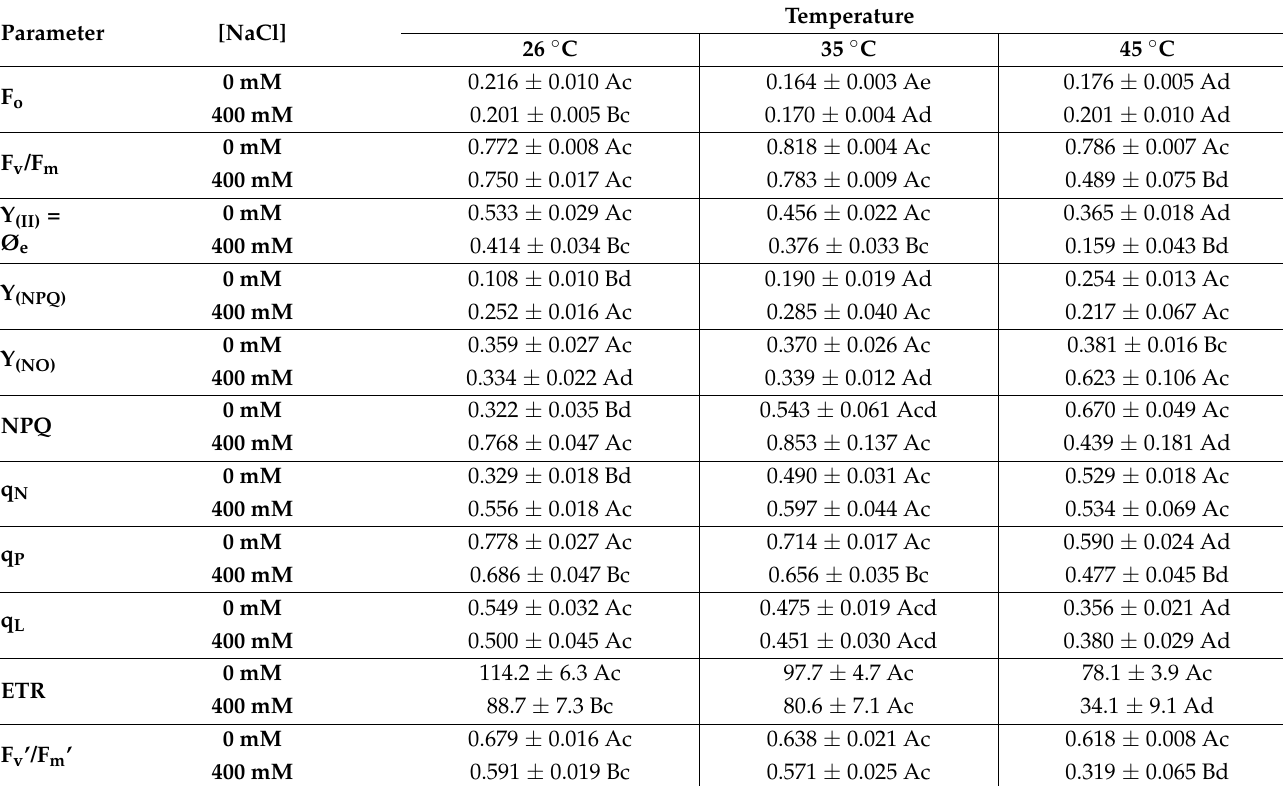
Table 1. Chlorophyll a fluorescence measurements C. glauca branchlets under the single and combined exposure to salt (0 and 400 mM NaCl) and temperature (26, 35 and 45 ◦ C) conditions. The parameters included: minimal fluorescence (F o ), maximal photochemical efficiency of PSII (F v /F m ) (both measured under dark-adapted conditions), the estimate of the quantum yield of non-cyclic electron transport (Y (II) = Φ e ), the quantum yield of regulated energy dissipation of PSII (Y (NPQ) ), the quantum yield of non-regulated energy dissipation (heat and fluorescence) dissipation of PSII (Y (NO) ), the photoprotective sustained thermal dissipation (NPQ), the non-photochemical quenching (q N ), the photochemical quenching based on the concept of separated (q P ) or interconnected (q L ) antennae, the electron transport rate (ETR), the PSII photochemical efficiency under photosynthetic steady-state conditions (F v ’/F m ’), the predictor of the rate constant of PSII inactivation (F s /F m ’), the chronic photoinhibition (PI Chr ), the dynamic photoinhibition (PI Dyn ) and the total photoinhibition (Total PI). Each value represents the mean ± SE of three to five independent measurements. Two-way ANOVA ( p < 0.05) followed by Tukey’s HSD test was performed for means comparison and different letters express significant differences between [NaCl] for the same temperature (A, B) or between temperature for the same [NaCl] (c, d, e) with A and c representing the highest